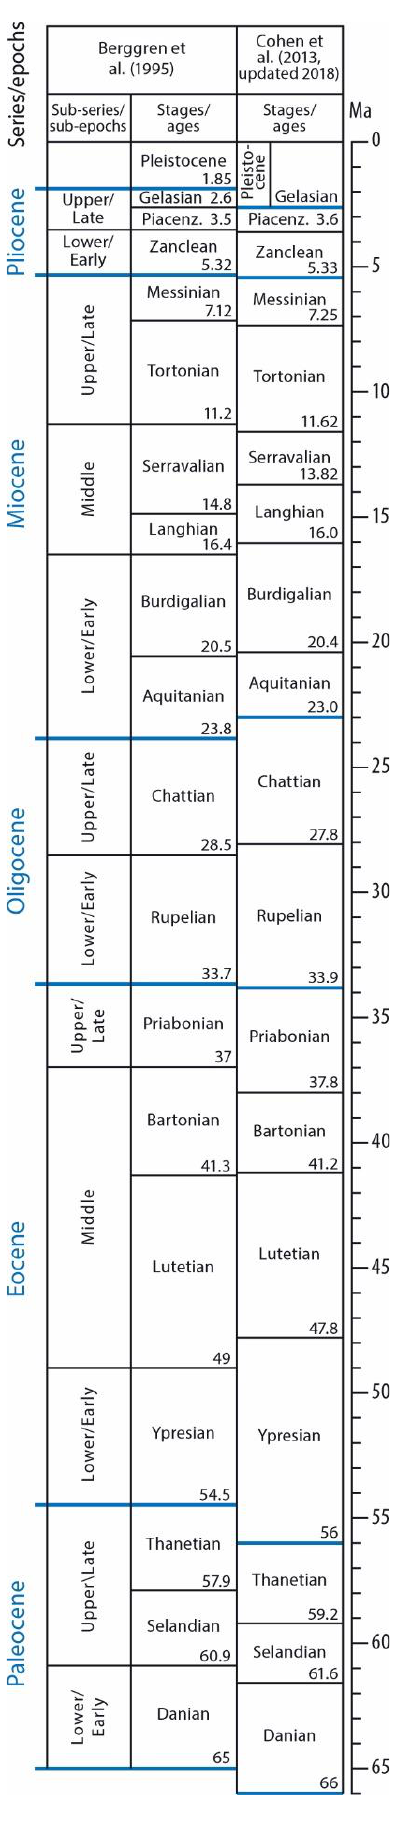
Table 1. Comparison of the Oligocene to Pleistocene time scale of Berggren et al. (1995) and Cohen et al. (2013). Note that after Berggren et al. (1995), series/epochs, sub-series/sub-epochs and stages/ages are all formal chronostratigraphic units. After Cohen et al. (2013), series/epochs and stages/ages are formal chrono- stratigraphic